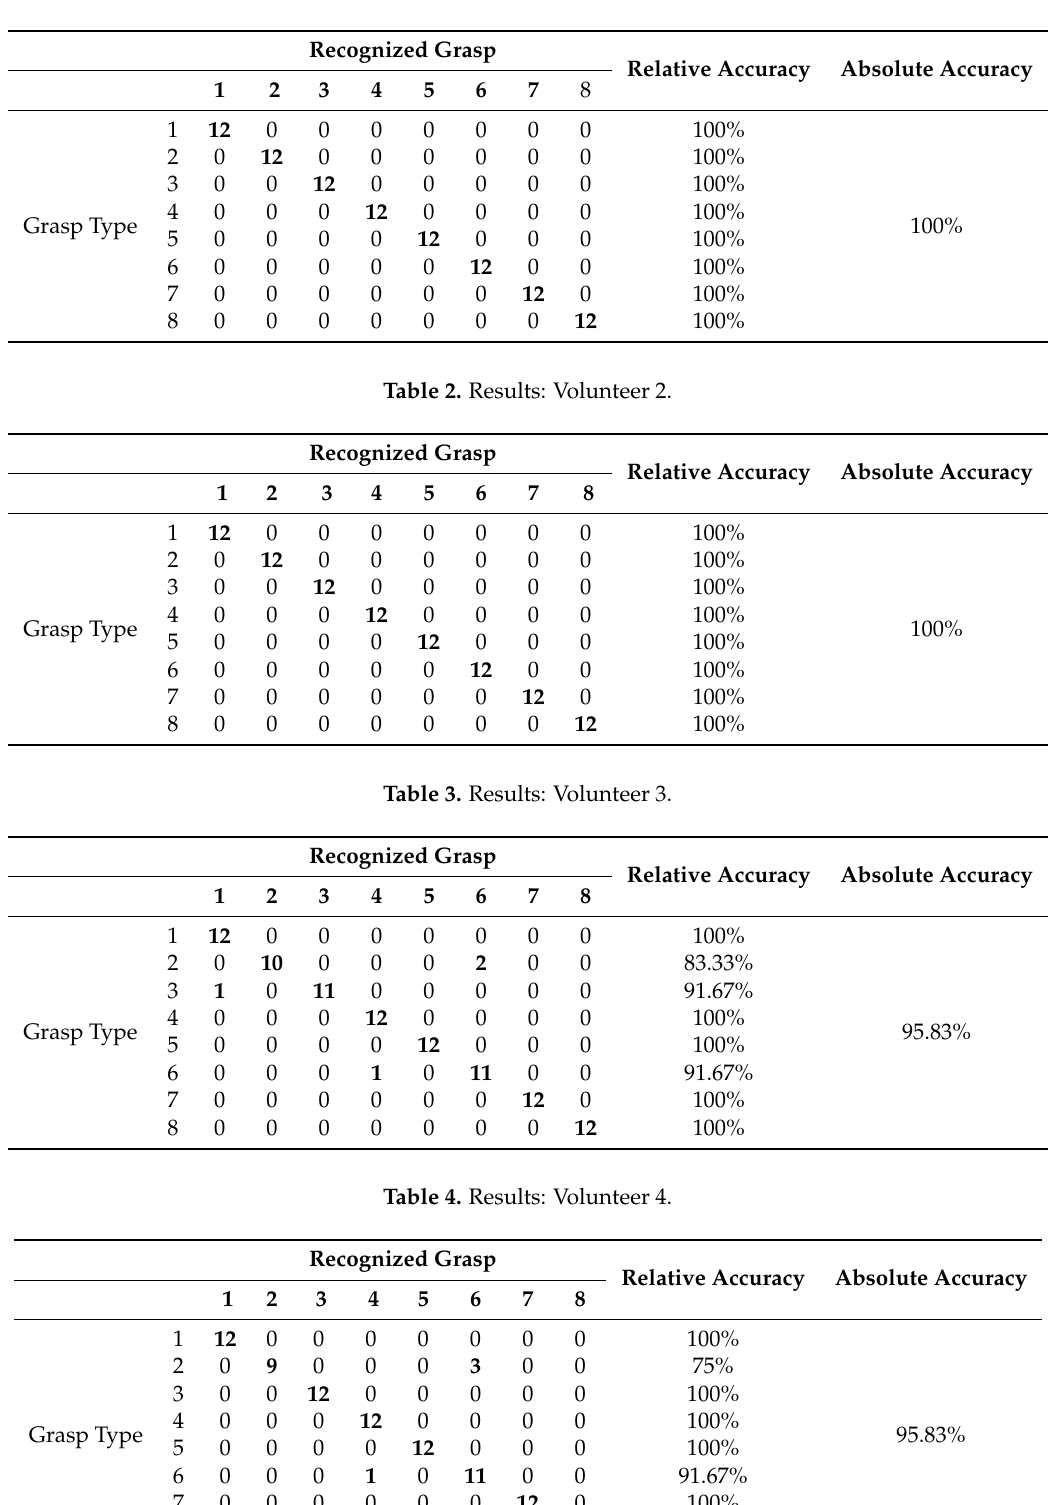
Table 1. Results: Volunteer 1.